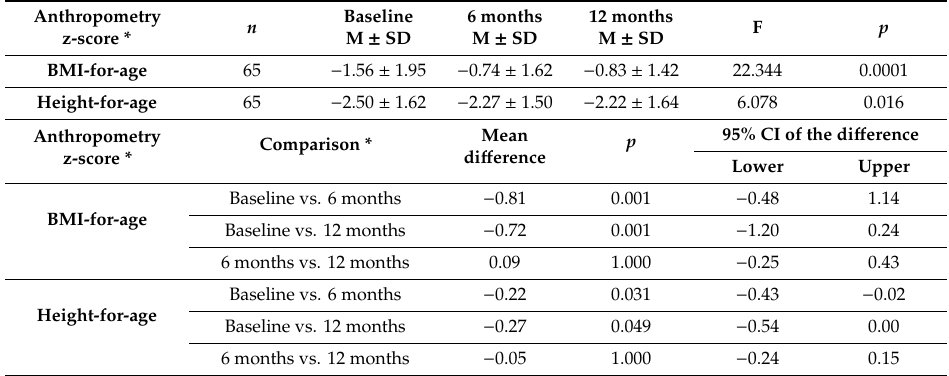
Table 1. Anthropometric outcomes following GT placement.